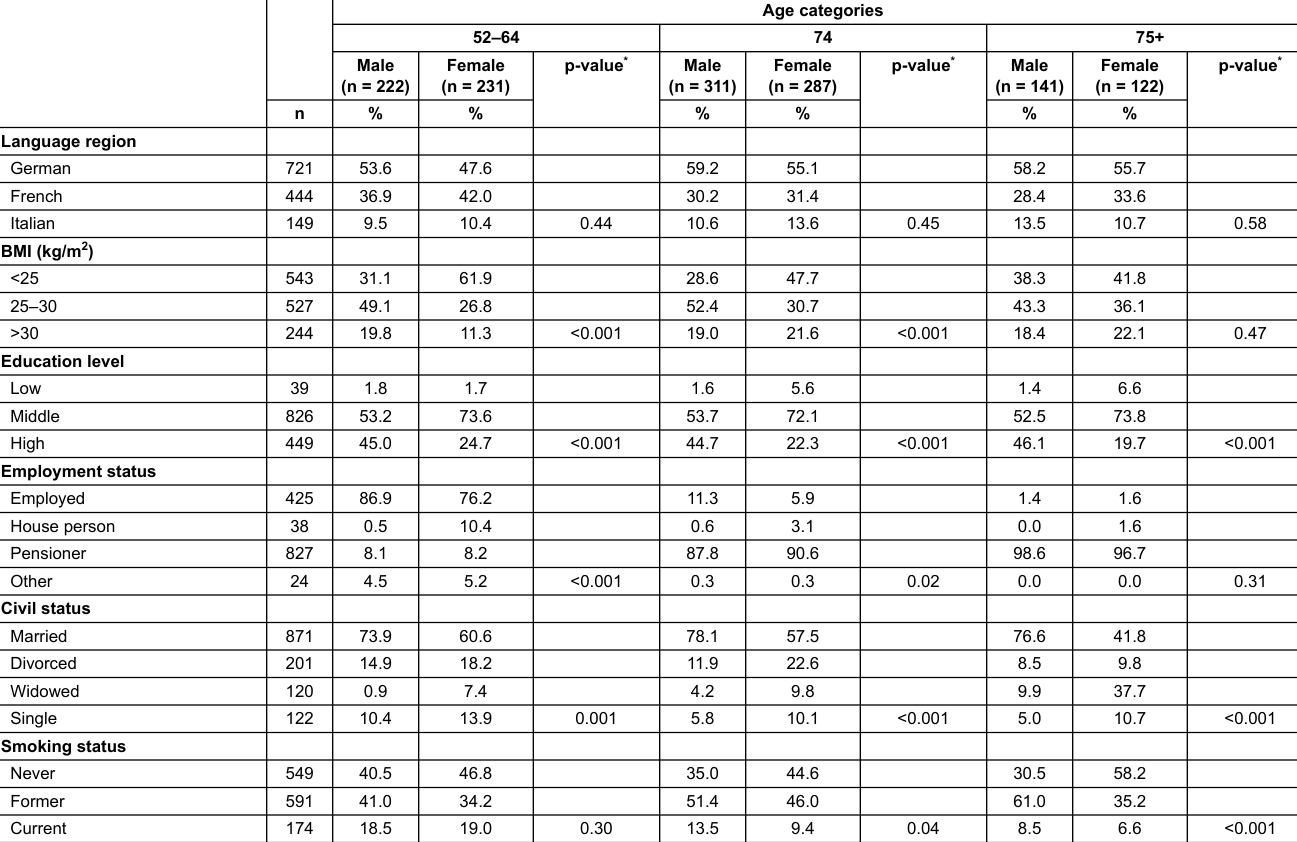
Table 2: Characteristics of participants in the SAPALDIA4 55+ accelerometer sub-study, by sex and age